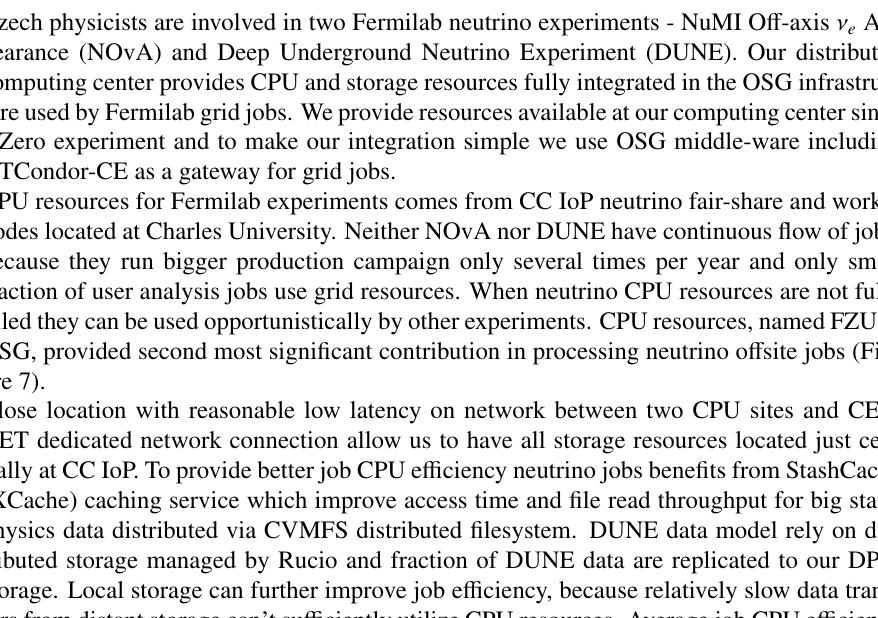
Figure 7. Computing sites CPU time contribution for Fermilab neutrino experiments (NOvA, DUNE) jobs eligible for o ff -site processing including our Prague (FZU)